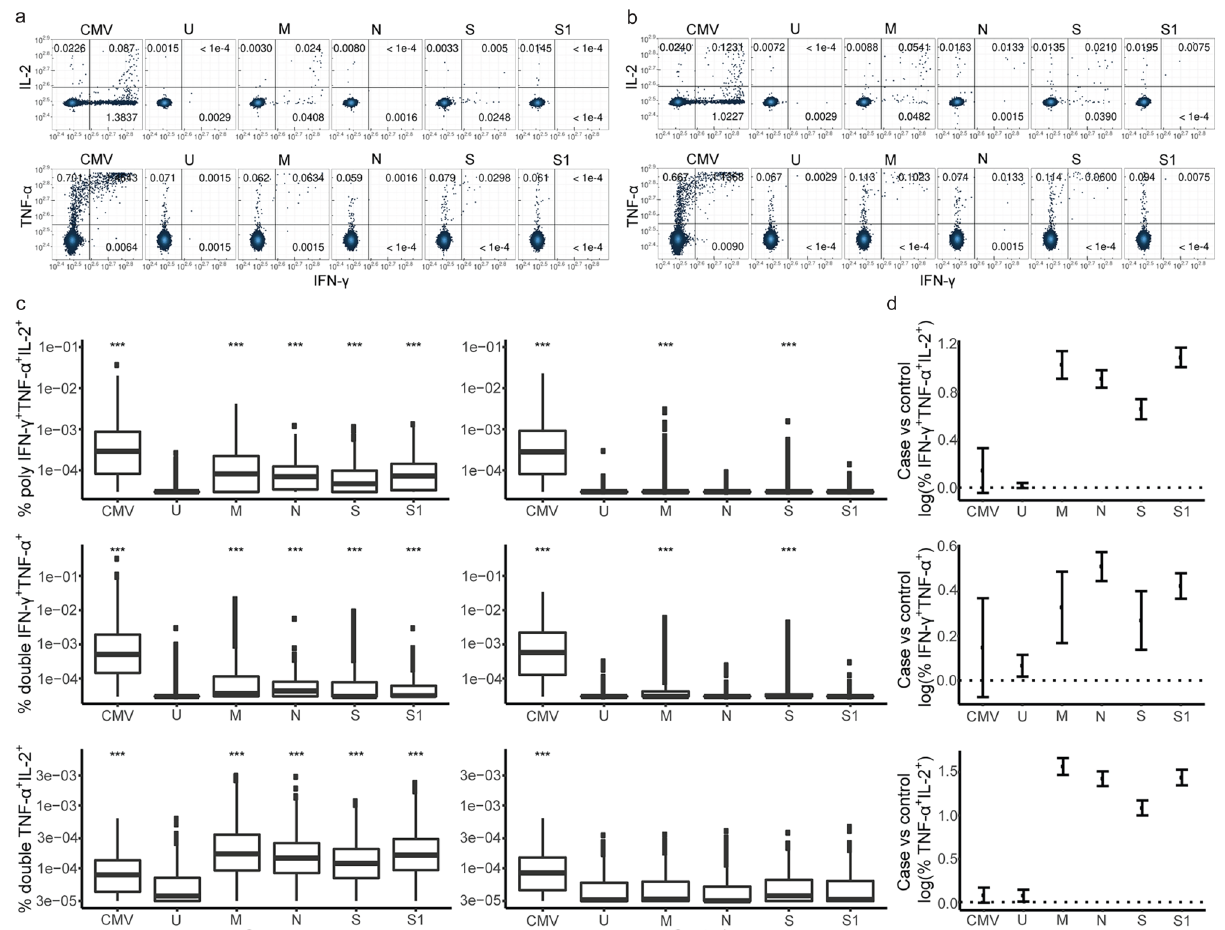
Fig. 1 Polyfunctional CD4 + T-cell responses are induced against all four SARS-CoV-2 proteins. Representative fl ow cytometry plots showing the cytokine response of SARS-CoV-2 reactive CD4 + T-cells from a an uninfected control and b a SARS-CoV-2 case for all stimulation conditions. The a uninfected control (sampled before March 2020) and b case (sampled after March 2020) samples come from the same individual. c Box plots show the frequencies of each CD4 + T-cell functional phenotype responding to the different stimulation conditions in SARS-CoV-2 cases ( n = 767) and uninfected controls collected during the pandemic ( n = 392). Data for polyfunctional (IFN- γ + TNF- α + IL-2 + ) and double-positive (IFN- γ + TNF- α + and TNF- α + IL-2 + ) CD4 + T-cells are shown. The bottom and top of the boxes correspond to the 25th (Q1) and 75th (Q3) percentiles, the line inside the box corresponds to the median, and the whiskers are located at max(min(Expression), Q1 – 1.5 IQR) and min(max(Expression), Q3 + 1.5 IQR), respectively (where IQR is the interquartile range = Q3 – Q1). *** P < 0.001 for indicated stimulation condition compared with unstimulated culture (U). d The plot shows estimates for the difference in the logarithm of the percentage of polyfunctional, double-positive IFN- γ + TNF- α + as well as TNF- α + IL-2 + CD4 + T-cells within the total CD4 + T-cell population responding to the different stimulation conditions between cases ( n = 767) and uninfected controls collected during the pandemic ( n = 392). The error bars indicate 95% con fi dence intervals (CI). The different stimulation conditions are a positive control (CMV), the unstimulated control (U), and the four different SARS-CoV-2 proteins (M, N, S, and S1). See also Supplementary Fig. 1 and Supplementary Table 2. Association between T-cell responses in different groups was tested by linear regression and signi fi cance was assessed with the standard linear regression t decreasing S1-reactive CD8 + T-cell responses (effect adjusted = − the only association observed with S-reactive CD8 + T-cell responses was with the non-classical HLA class I allele HLA- G * 01:04 (effect = 0.51, 95% CI: 0.38, 0.65, P = 7.5e-14) and no signi fi cant association was observed between HLA alleles and M-reactive CD8 + T-cell responses. Increasing CMV-reactive CD8 + T-cell responses associated with HLA-C * 07:02 (effect = 0.82, 95% CI: 0.53, 1.11, P = 3.8e-8) and HLA-B * 07:02 (effect = 0.84, 95% CI: 0.54, 1.14, P = 5.8e-8), again HLA- C * 07:02 is de fi ned as the lead signal based on the slightly better P value. The only association we observed between HLA alleles and CD4 + T-cell responses was between higher M-reactive poly- functional CD4 + T-cell responses and HLA-DQA1 * 05:05 (effect = 0.59, 95% CI: 0.39, 0.80, P = 1.4e-8; Table 2). No